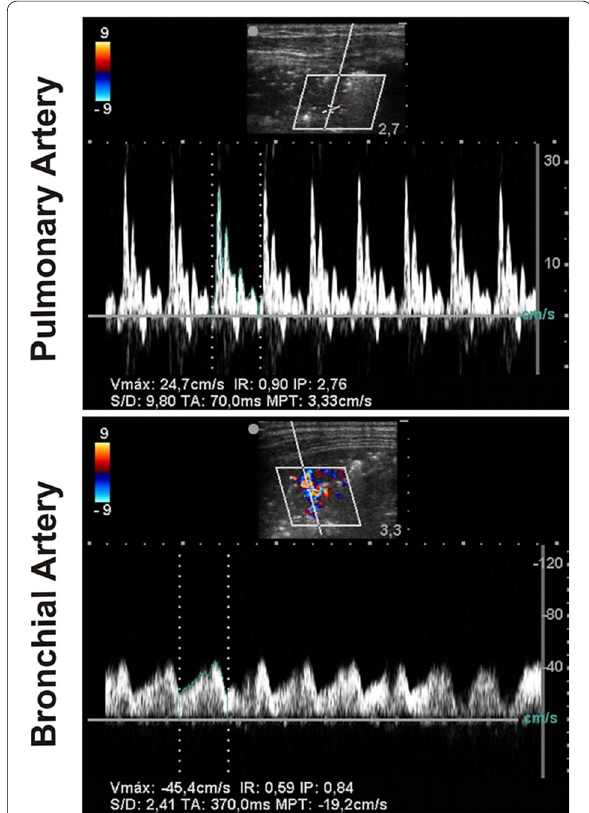
Fig. 3 Spectral Doppler analysis of the three types of vessels within the lung. Spectral Doppler analysis of a pulmonary artery ( upper ) and a bronchial artery ( lower ) within a representative anesthesia‑induced atelectasis in 4‑year‑old patient. Spectral Doppler was performed dur‑ ing a brief expiratory pause. Pulmonary artery showed lower Doppler maximal velocity and higher resistance (IR) and pulsatile (IP) indexes than the bronchial artery presumably due to hypoxic pulmonary